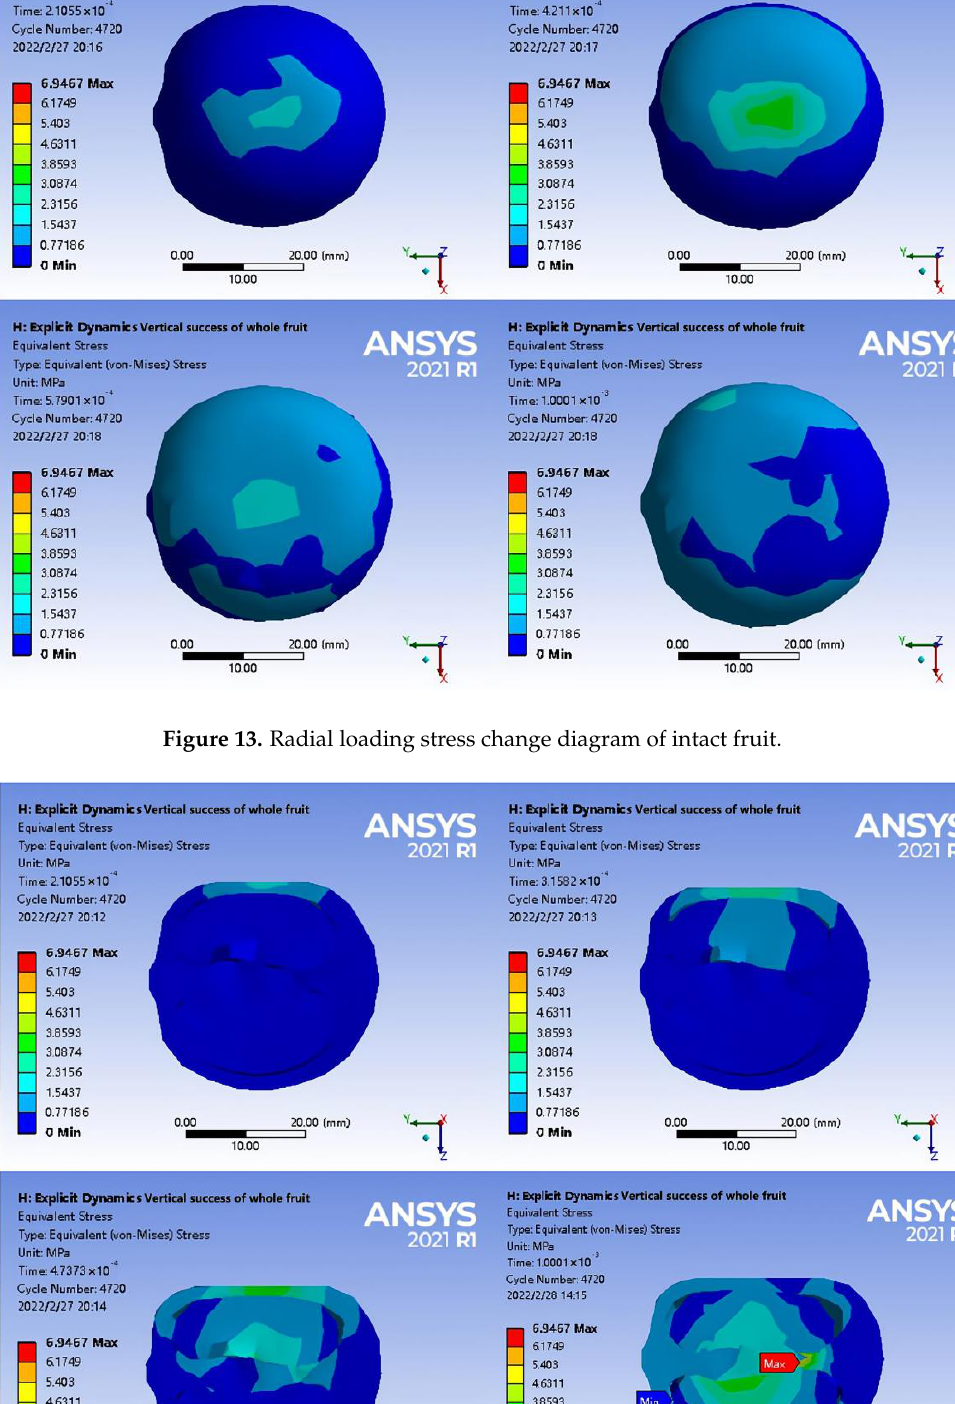
Figure 13. Radial loading stress change diagram of intact fruit.